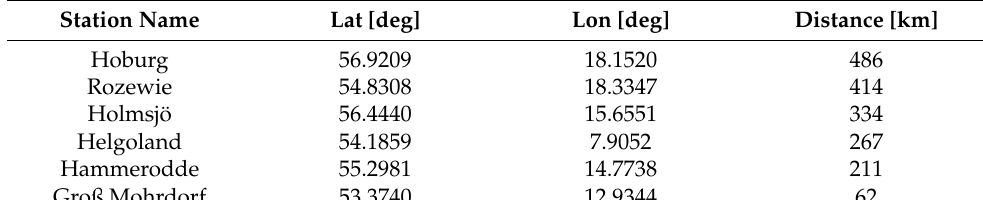
Table 1. Distance between the transmitters and the centre point of the test area.